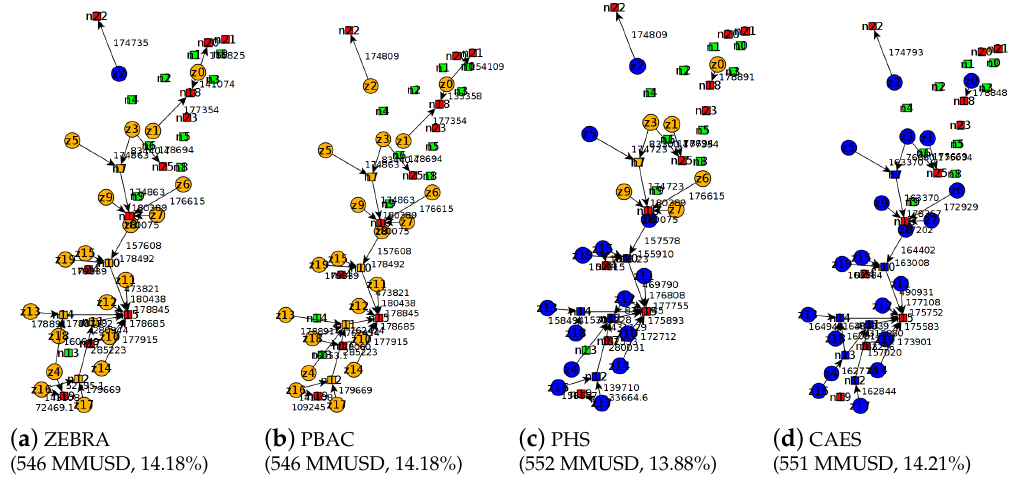
Figure 13. Results for technological ESS comparison in P50 (squares = substations ( V 2 ∪ O ); circles = generation zones ( V 1 ); green = unselected; orange = selected; red = sales node ( O ); blue = storage system).